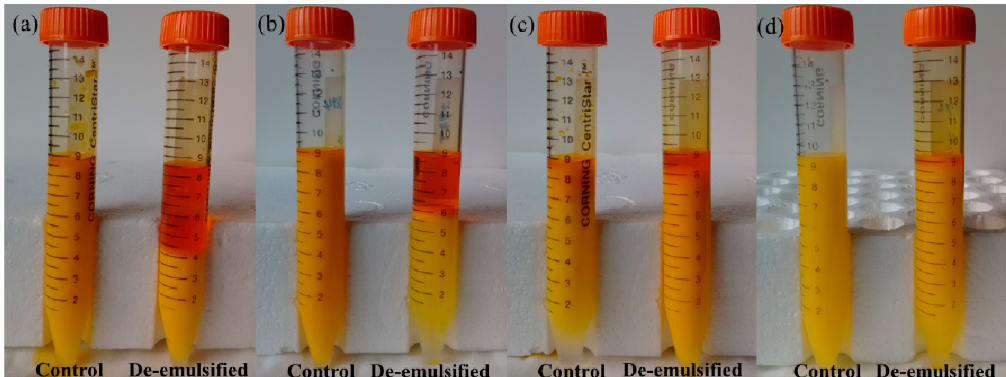
Figure 6. Comparative photographs of de-emulsified emulsions with TAPM; ( a ) Emulsion I, TAPM A; ( b ) Emulsion II, TAPM A; ( c ) Emulsion II, TAPM B; and ( d ) Emulsion III, TAPM A.